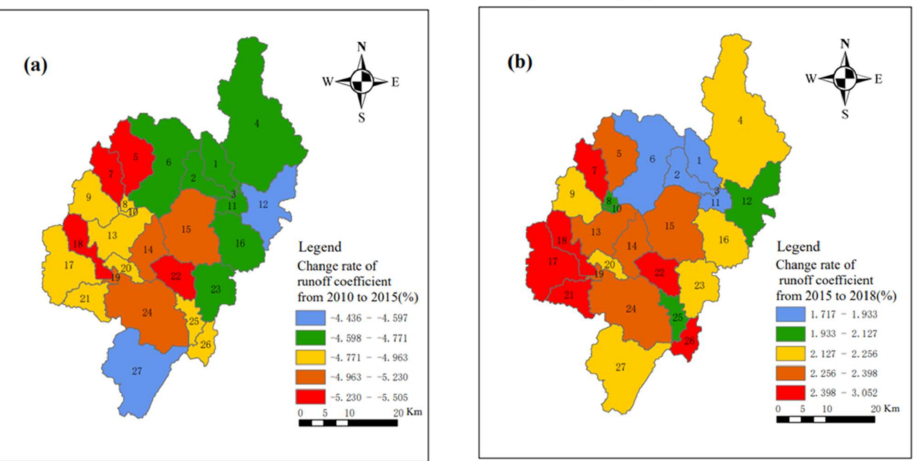
Figure 8. ( a ): Variation of runoff coefficient from 2010 to 2015. ( b ): Variation of runoff coefficient from 2015 to